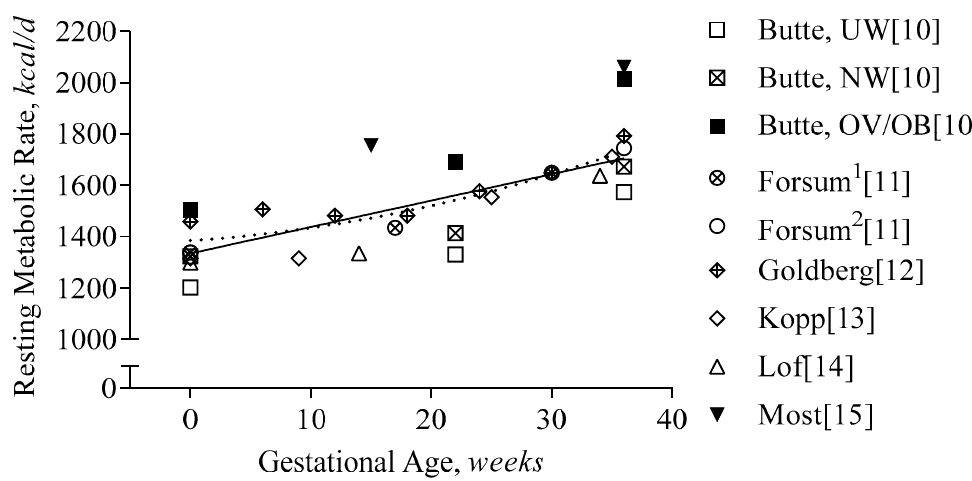
Figure 3. Resting Metabolic Rate during Gestation. Resting metabolic rate is presented per study and gestational age (GA). The regression line represents the average increase in the resting metabolic rate during gestation (RMR[ kcal / d ] = 1334 + 10.3 × GA[ weeks ], R 2 = 0.55, using non-linear regression (pointed line) did not improve the prediction, R 2 = 0.57). Forsum 1 and Forsum 2 indicate the two di ff erent cohorts in the study: both measured before pregnancy, but at di ff erent times during gestation; Butte reported the changes in RMR per BMI class: ‘UW’ indicates underweight: BMI ≤ 19.8 kg / m 2 , ‘NW’ indicates normal weight: BMI 19.8–26 kg / m 2 , and ‘OV / OB’ indicates overweight / obesity: BMI ≥ 26 kg / m 2